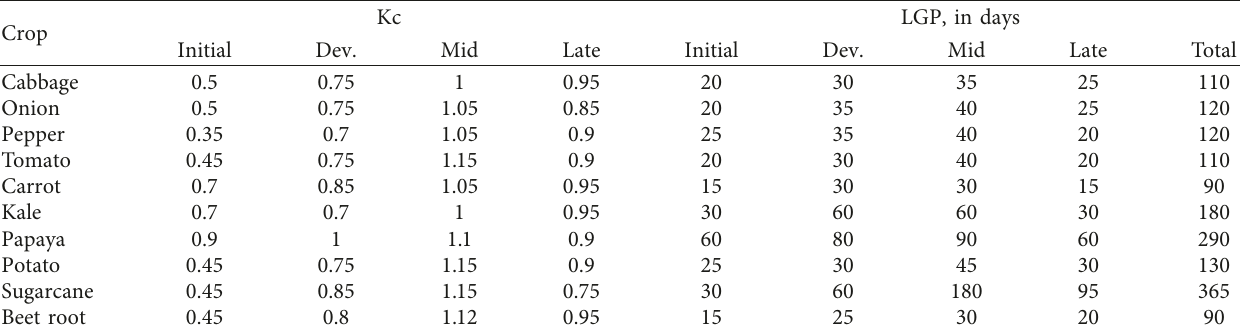
Figure 3: Flowchart showing procedures in the estimation of irrigation water Table 3: Crop coefficient and length of the growing period used for CWR computation.